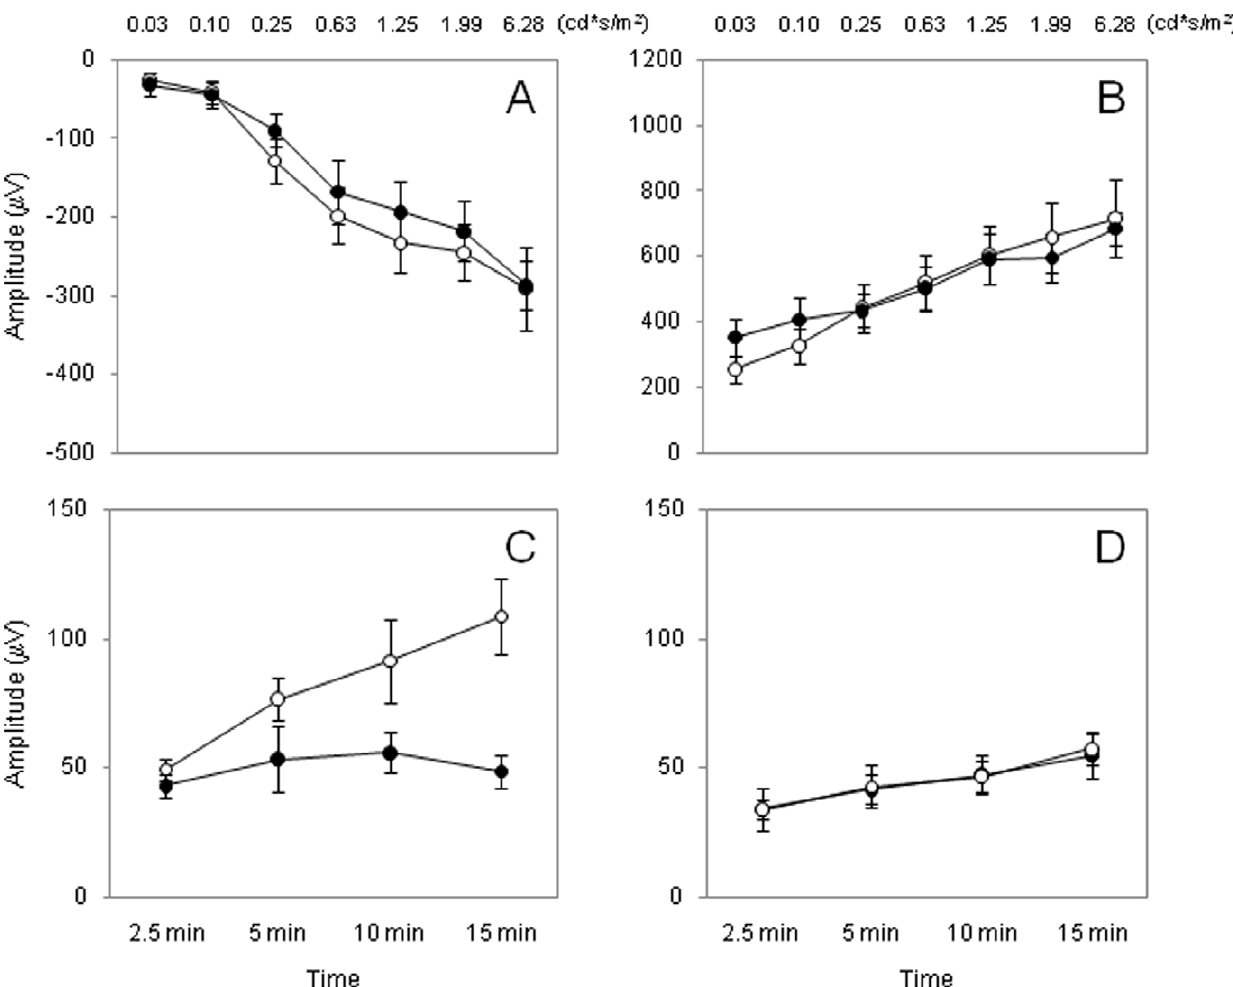
Figure 4. Quantification of the scotopic and photopic ERGs of WT and MT1 2 / 2 mice recorded after 18 (CT 6) and 30 (CT18) h in DD. No differences in the amplitude of the a- and b-wave were observed in the scotopic ERGs of WT mice (A, B). The photopic ERGs show a circadian regulation in WT (C, Two-way ANOVA, P , 0.01, N=6–8 for each time-point) but not in MT 1 2 / 2 mice (D, Two-way ANOVA, P . 0.1, N=6–8 for each time-point). White Circles=CT6; Black circles=CT 18.